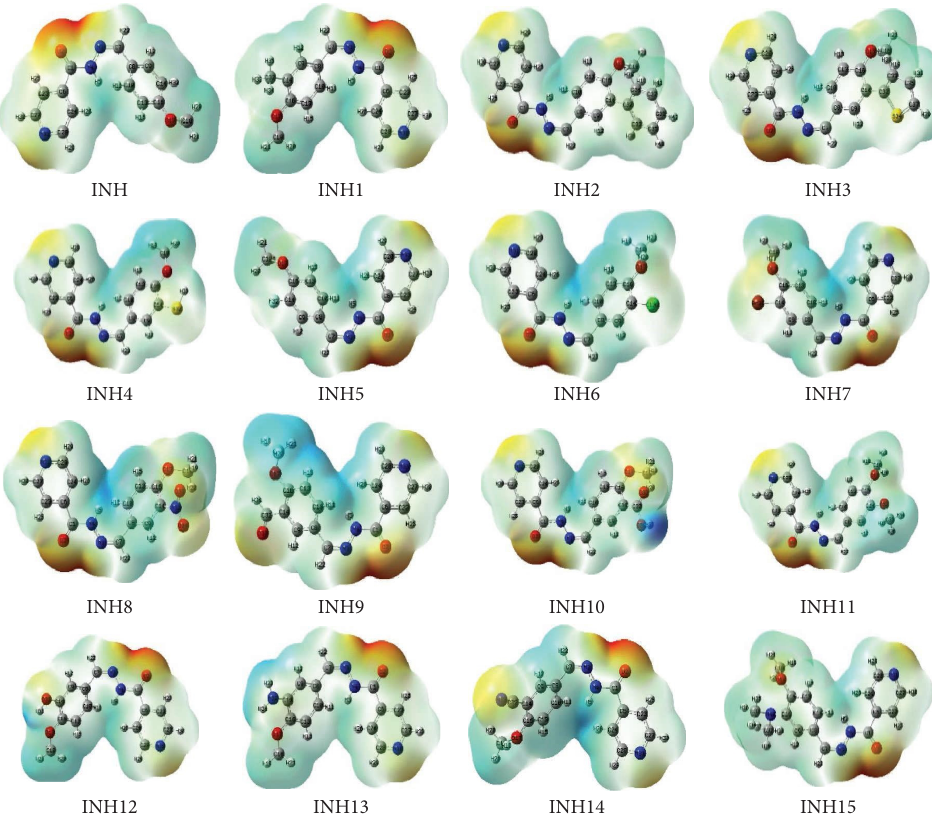
Figure 3: Molecular electrostatic potential plots of the compounds under investigation, calculated at the B3LYP-D/6-311G (d,p) level of theory in the gaseous phase. Table 2: Reorganization energies, adiabatic electron afnity, vertical electron afnity, vertical ionization potential, adiabatic ionization potential, and hardness of the studied compounds all in eV, computed at the B3LYP-D/6-311G (d,p) level of theory in the gaseous phase.